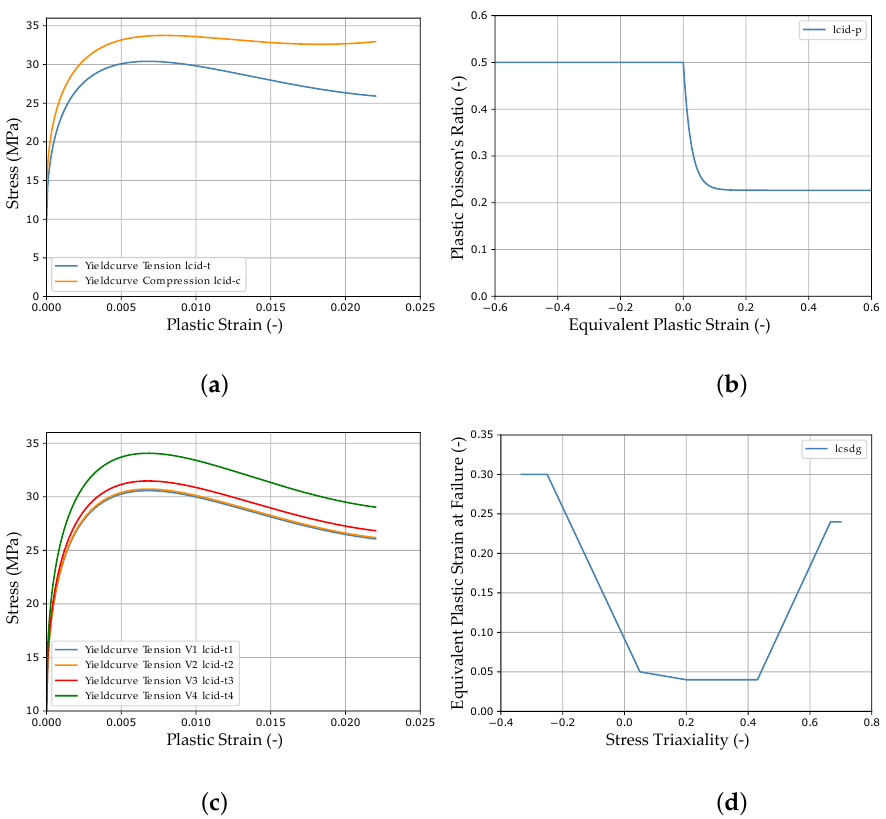
Figure 4. Material card analytical input curves, calculated with the target parameters of the vir- tual experimental dataset: ( a ) lcid-t and lcid-p for plasticity and tension–compression asymmetry; ( b ) lcid-p for variable plastic Poisson’s ratio; ( c ) lcid-t1 to lcid-t4 for strain rate dependency and ( d ) lcsdg for